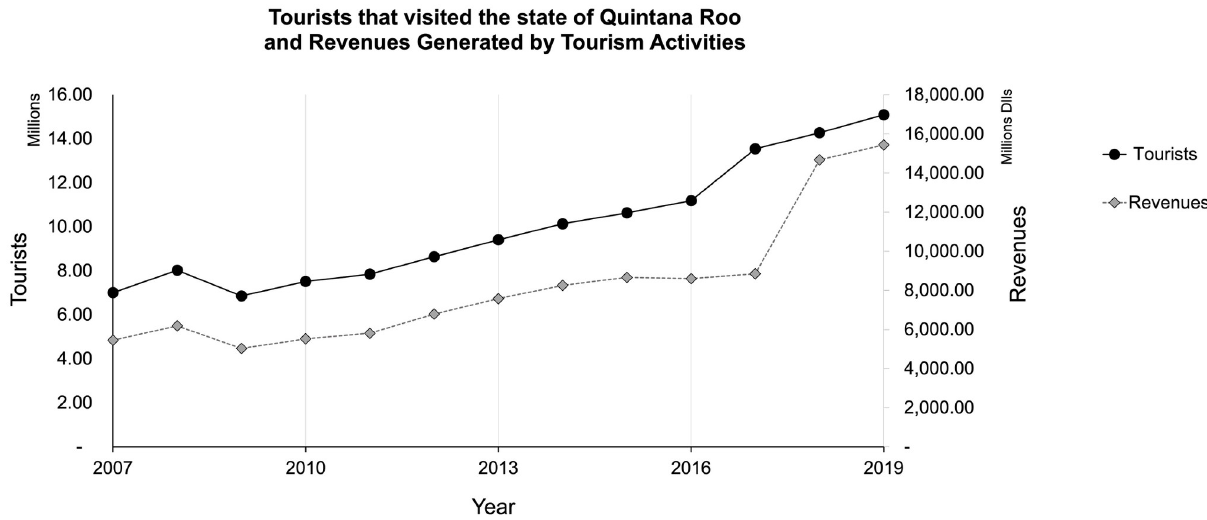
Fig 4. Tourists that visited the state of Quintana Roo and revenues generated by these visitors. Sources for the figure [36, 47, 57, 62].